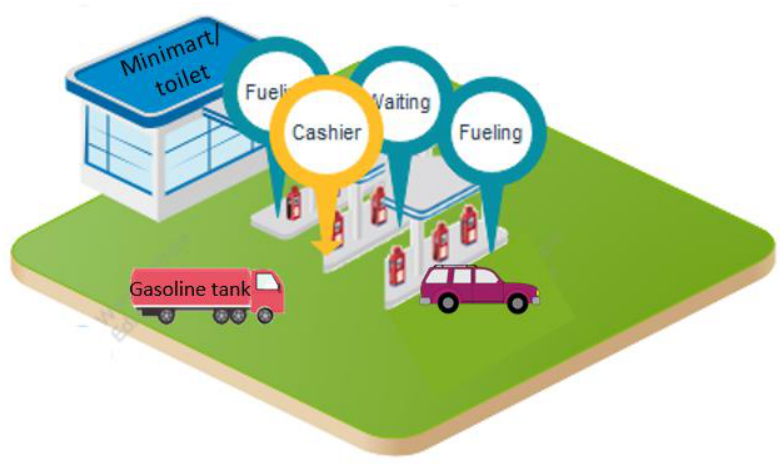
Figure 1. Gasoline station layout.